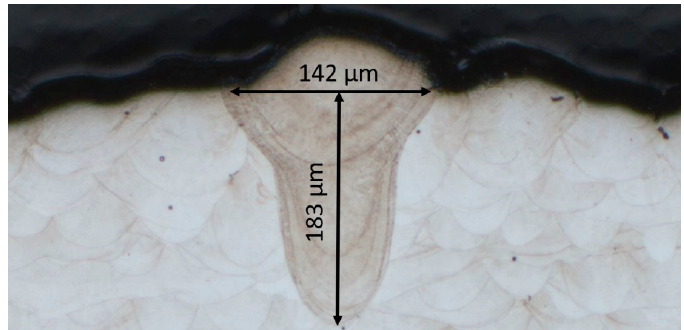
Figure 5. Single laser track of 150 W and 800 mm/s applied onto a bulk material showing the measured